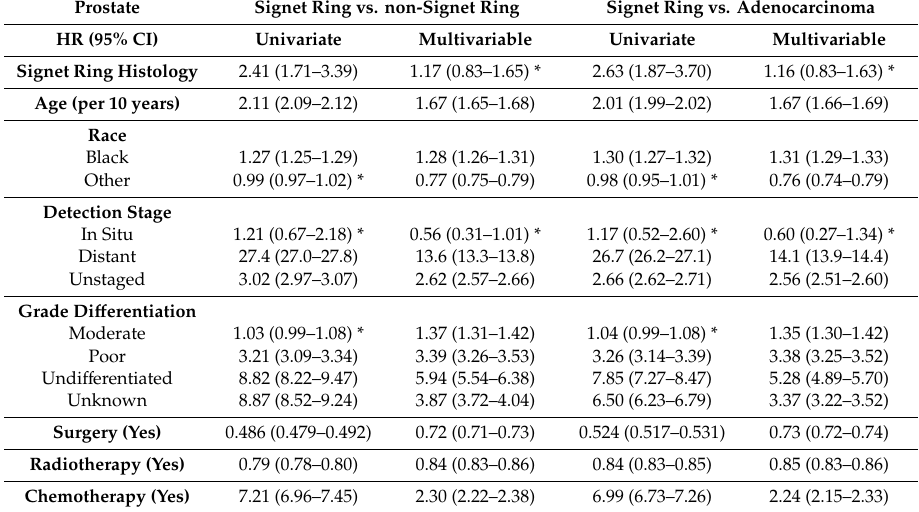
Table 26. Derived univariate and multivariable Cox-proportional hazard ratios (HR) of mortality for prostate cancers. Signet Ring vs. non-Signet